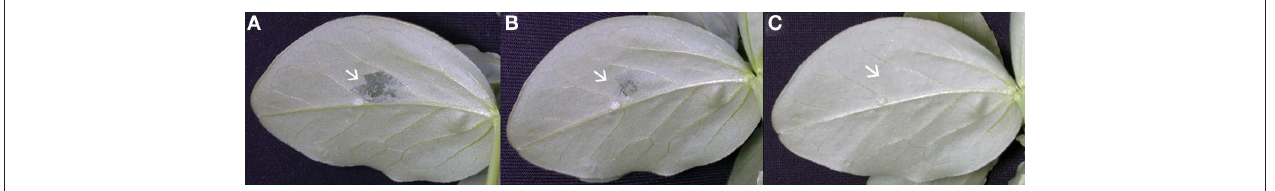
Figure A1 | Dye-loaded leaf apoplast of Vica faba L. To prepare a leaf for measurement, dye is partially loaded into the leaf apoplast. The loading procedure can be monitored by the darker appearance of the leaf apoplast. This dark shade disappears after the water has left the leaf through the stomata